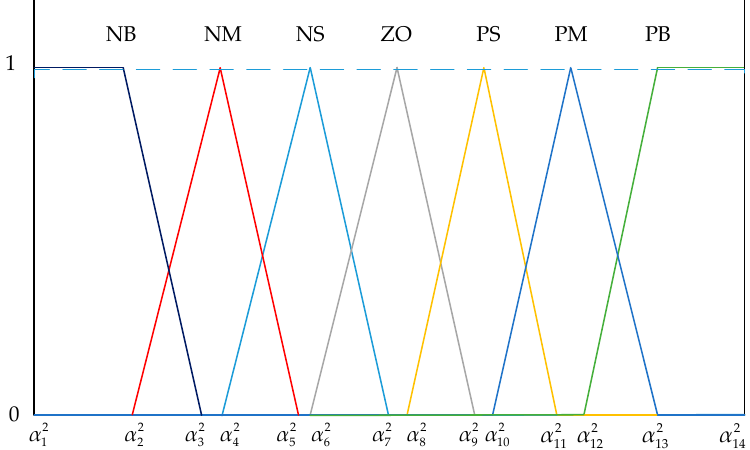
Figure 5. Membership function of the corresponding derivative.